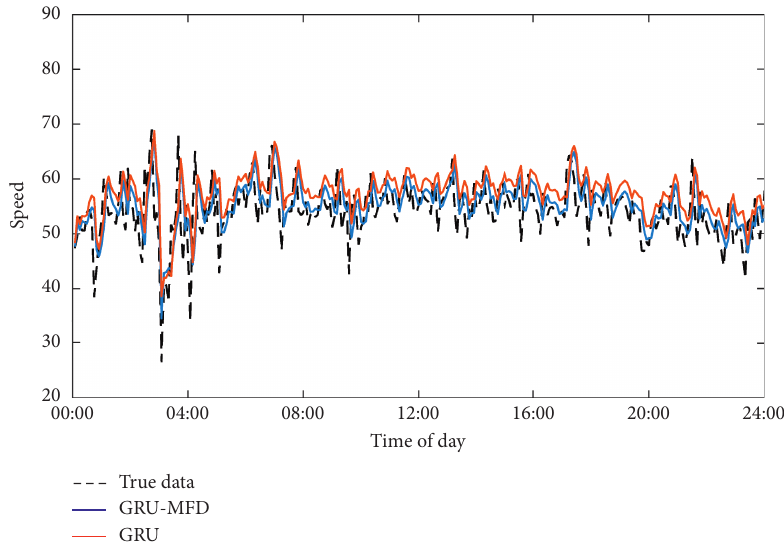
Figure 20: Prediction results on July 11, 2018, Section 2.